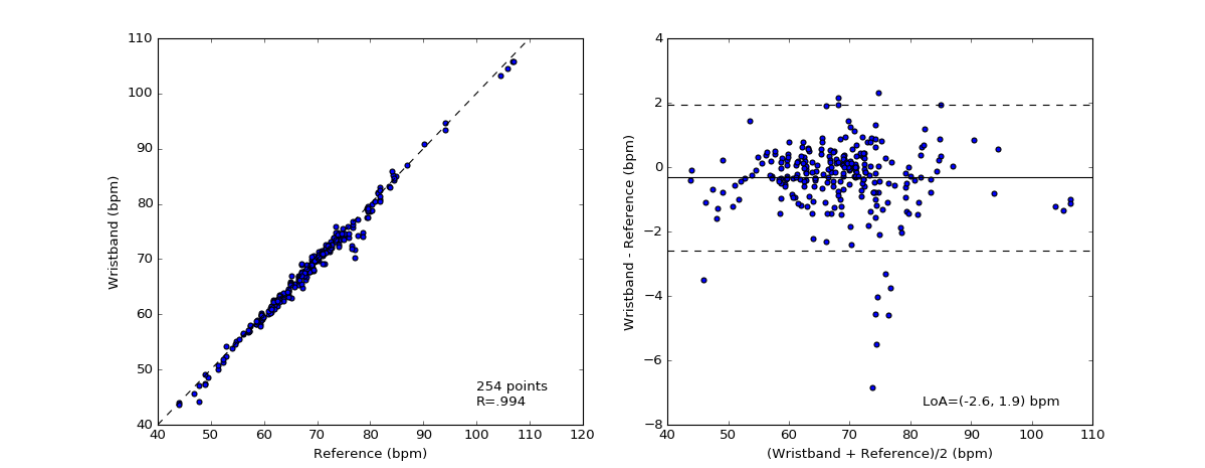
Figure 6. The distribution of measured heart rate (HR) by the electrocardiography (ECG) and the wristband (left). The Pearson correlation coefficient is shown in the lower-right corner of this scatter plot. Bland-Altman plots of the absolute error of HR between the wristband and the simultaneously recorded ECG measurements versus the mean of the measurements in beats per minute (right). The solid black line indicates the mean difference. The dotted lines mark the 95% limits of agreement (LoA) at −2.6 and 1.9 bpm.